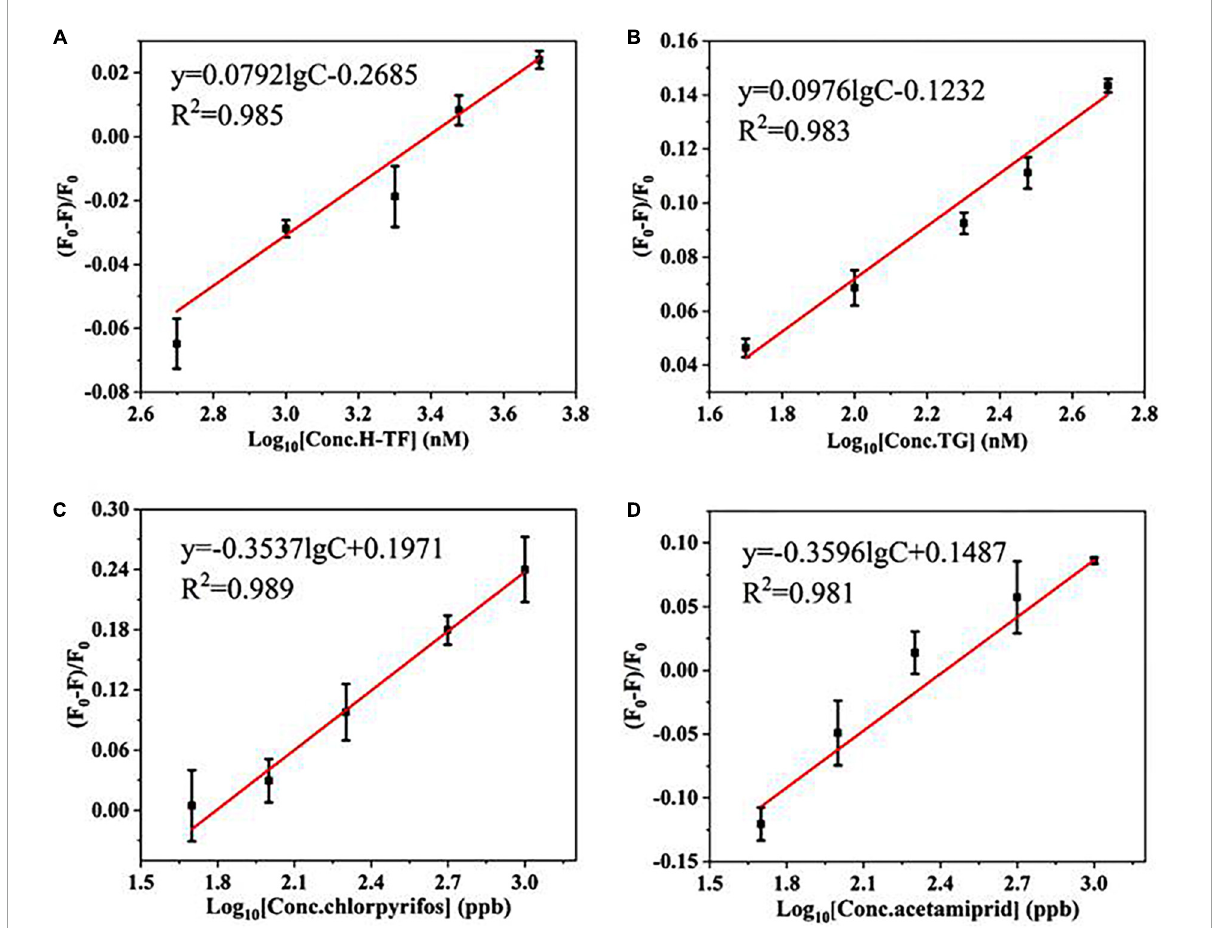
FIGURE3 The linear relationship between (F 0 –F)/F 0 and the concentrations of targets: (A) human transferrin (H-TF, 50–500 nM); (B) bovine thyroglobulin (TG, 50–500 nM); (C) chlorpyrifos (50–1,000 ppb); (D) acetamiprid (50–1,000